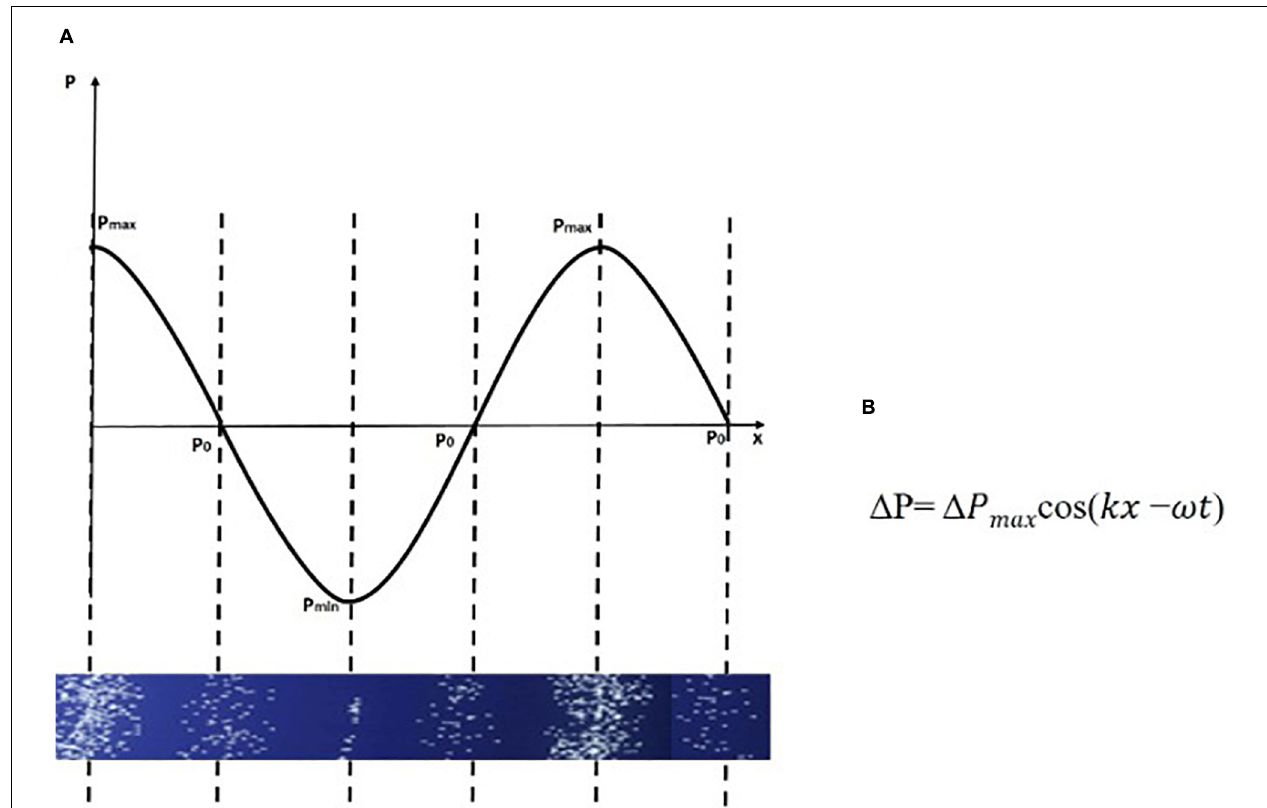
FIGURE 11 | (A,B) A harmonic curve P(x) associated with the concentrations of air particles in